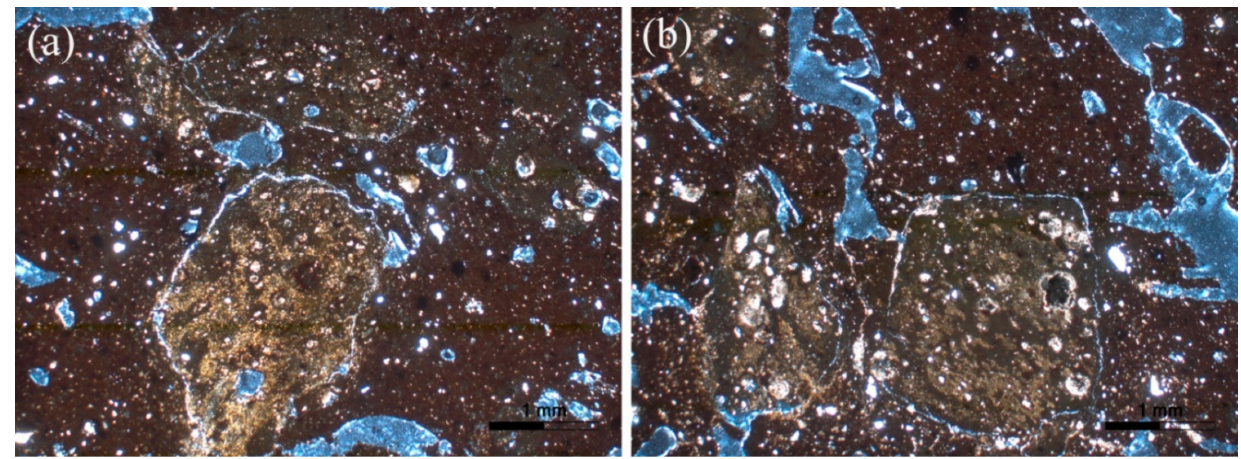
Figure 5. Representative photomicrographs of group 3: ( a ) sample K8 and ( b ) sample K84. All photomicrographs are taken under crossed Nicols (XP).